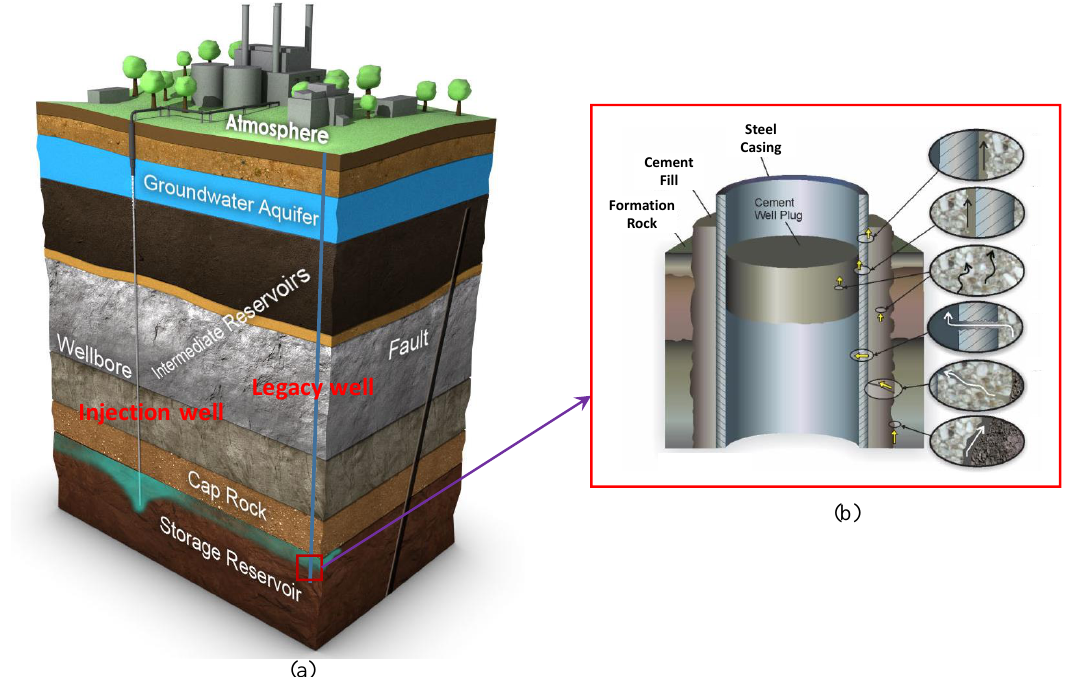
Figure 1. Schematic section of a compromised well: ( a ) Geologic block [24] and ( b ) possible fluid leakage path [8].